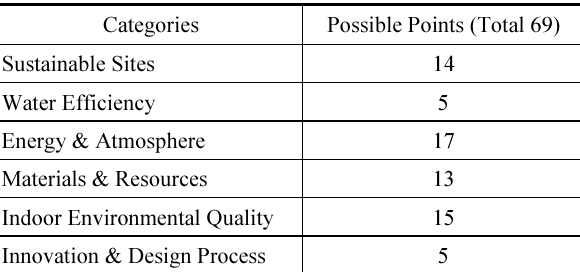
Table 2. The LEED rating